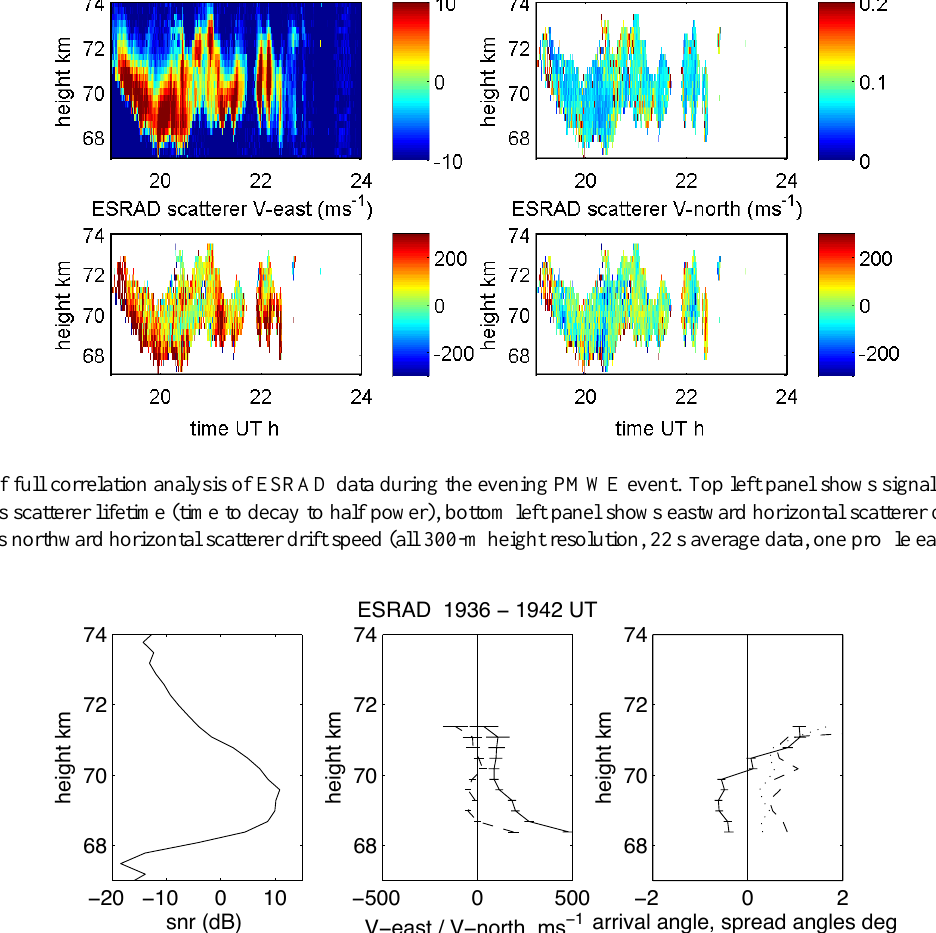
Fig. 9. Profiles of the results of ESRAD analysis averaged between 19:36–1942 UT. In this figure, the analysis has been performed for the 6 separate 20-s time intervals when data were collected in the alias 300 mode. The results have then been averaged. First panel shows signal-to-noise ratio. Second panel shows eastward (solid line) and northward (dashed line) scatterer travel speeds. Third panel shows mean arrival angle (solid line) and angular spread in maximum (dashed line) and minimum (dotted line) directions. Error bars are statistical uncertainties estimated as described in Sect. 2.3. For clarity, error bars are not plotted for the two curves showing angular spread – for these the incertainties are ca. ± 0.5 ◦